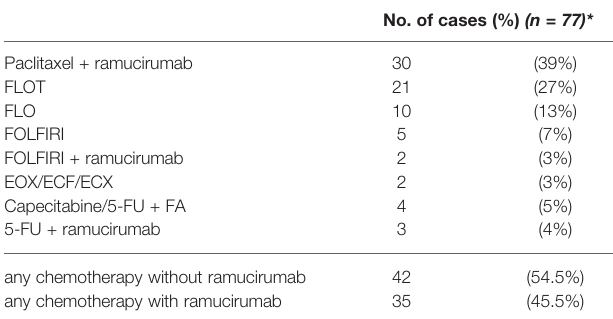
TABLE 4 | History of chemotherapy regimens preceding PIPAC treatment. No. of cases (%) (n = 77)*